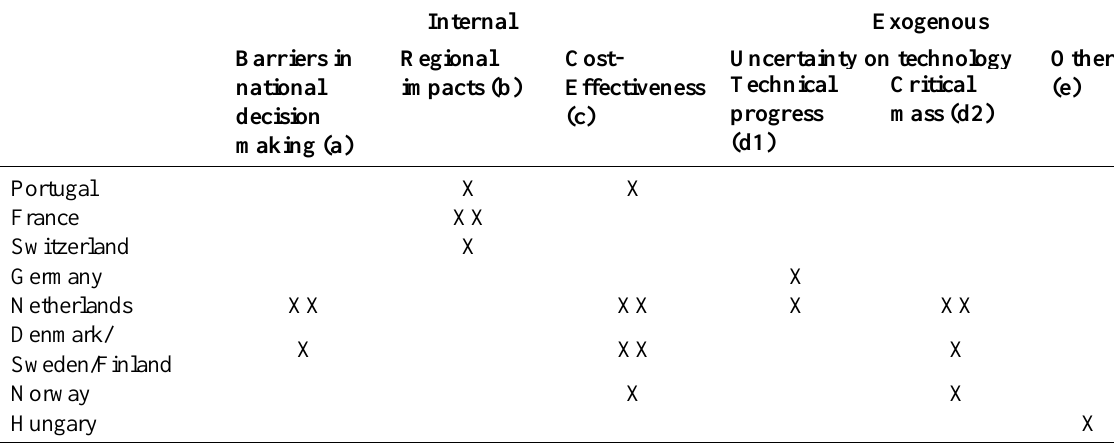
Internal Exogenous